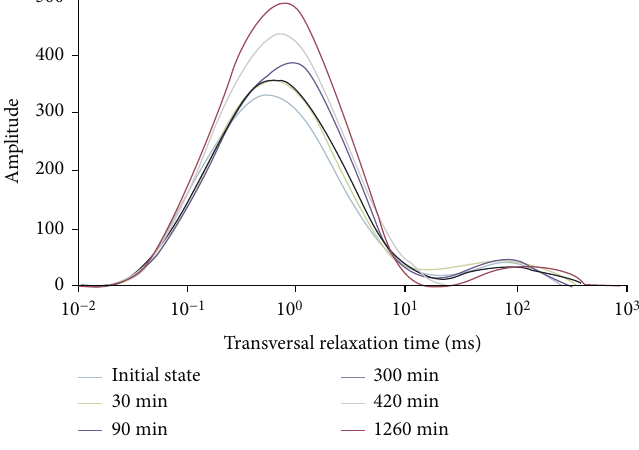
Figure 8: T spectra of one sample during water-shale interaction in Bin et al. ’ s [76] tests. 2